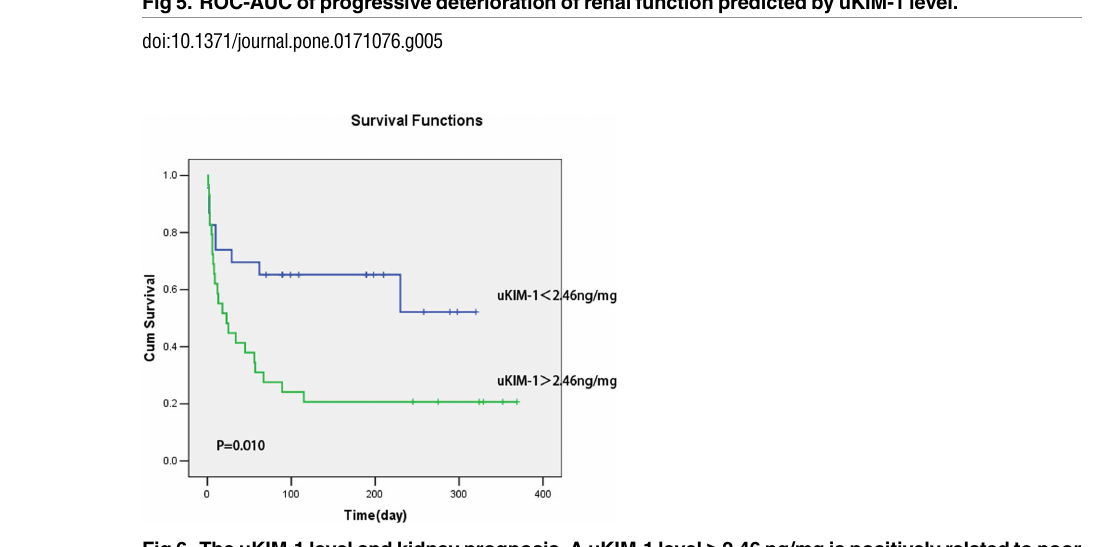
Fig 6. The uKIM-1 level and kidney prognosis. A uKIM-1 level > 2.46 ng/mg is positively related to poor